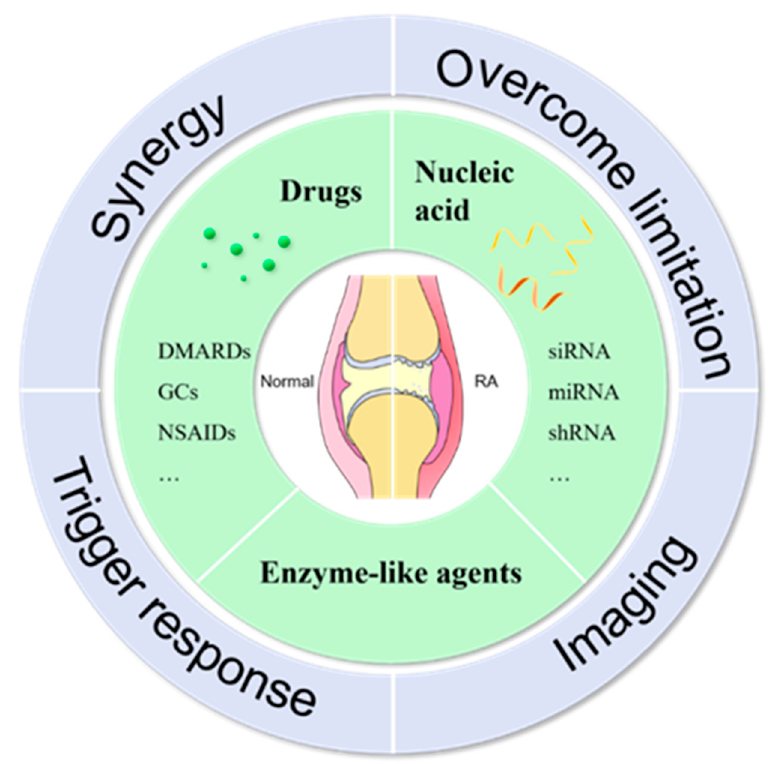
Figure 3. Commonly used drugs for the treatment of rheumatoid arthritis include: Small molecule drugs, nucleic acid drugs, and enzyme-like agents that co-deliver different drug mechanisms to relieve of inflammation, overcome the therapeutic limitations of individual therapies, enable imaging, and activate response molecules within the delivery system to trigger response-based therapy.